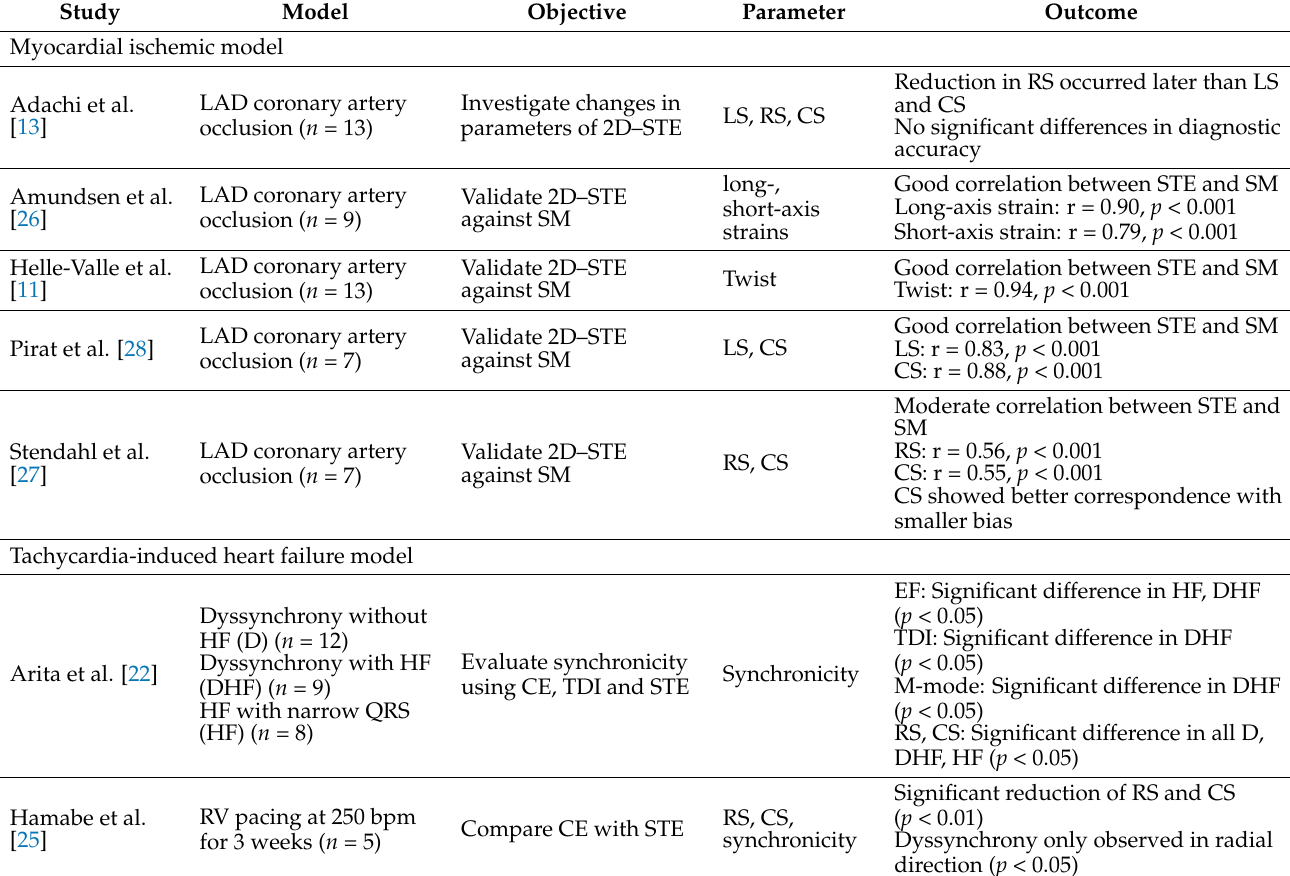
Table 1. Studies of canine experimental models with two-dimensional speckle tracking echocardiography